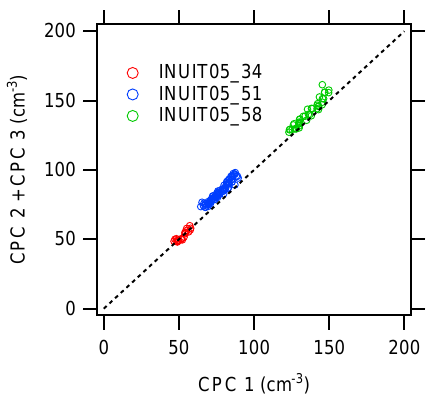
Figure 11. Comparison of the total particle number concentration in AIDA to the sum of residuals in the output flow and interstitial particles in the pump flow. The dashed line represents 1 :